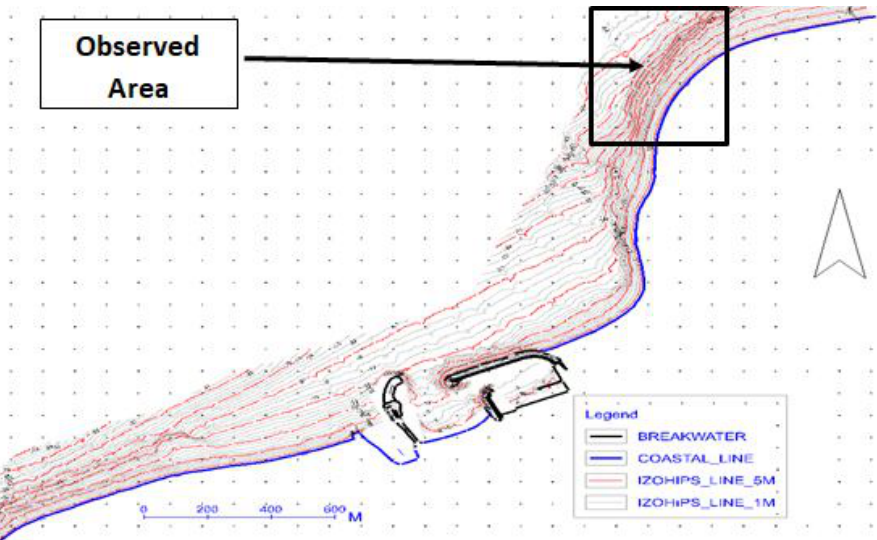
Figure 14. Bathymetric survey plan for the sea-experiment area.